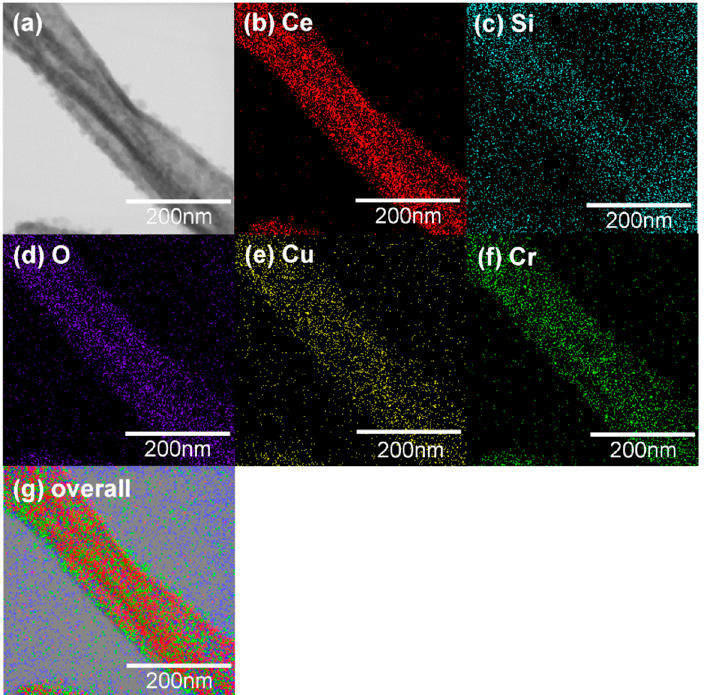
Figure 7. ( a ) STEM image of CeO 2 -CuCrO 2 nanofiber, ( b ) Ce, ( c ) Si, ( d ) O, ( e ) Cu, ( f ) Cr. ( g ) Overall STEM-EDS mapping of Ce, Si, O, Cu and Cr present in CeO 2 -CuCrO 2 nanofiber.